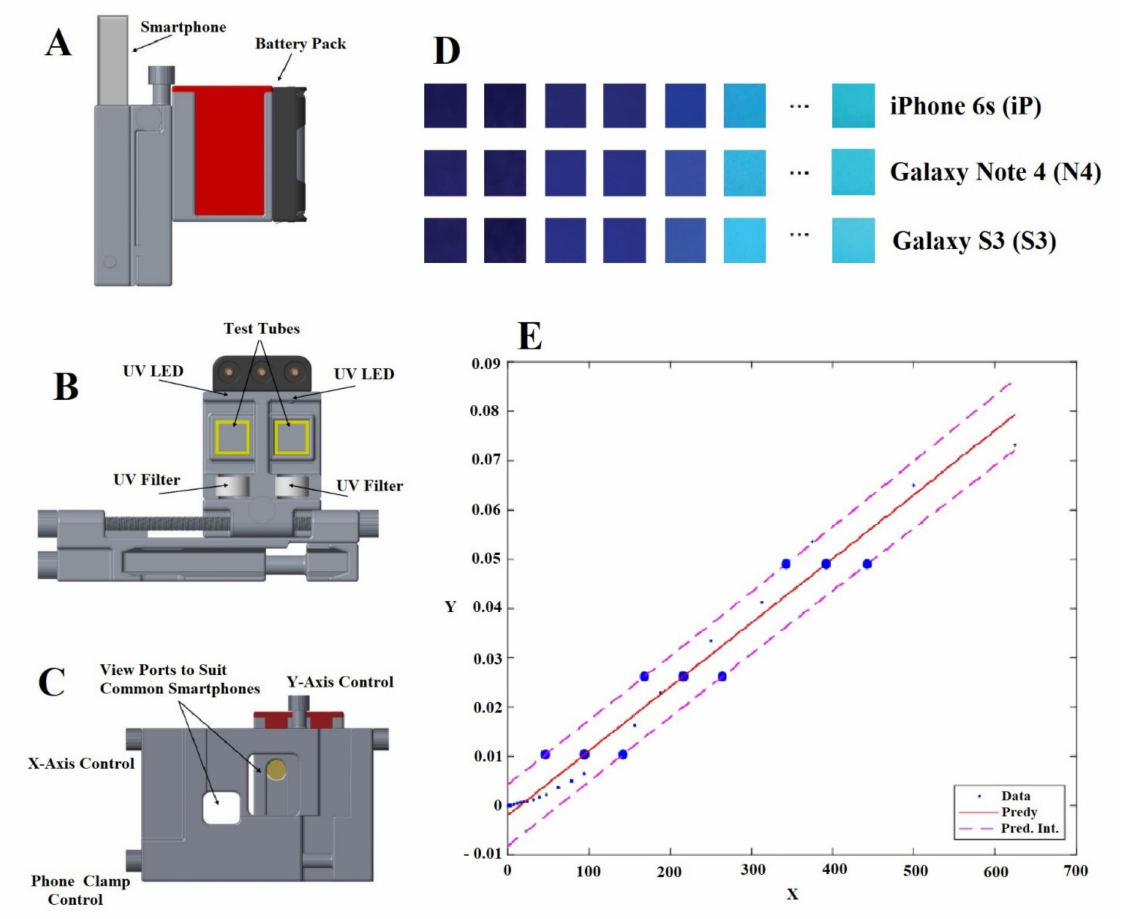
Figure 7. ( A ) external and ( B ) internal design of imaging housing attached to a smartphone and ( C ) adjustable viewports and clamp controls for the AIEgen-based 3D printing device. ( D ) Images of different HSA concentration levels taken by 3 smartphones after the AIEgen, BSPOTPE, was added. ( E ) Linear prediction model with internals with the x -axis of HSA concentration and the y -axis of light intensity of the AIEgen probe after it was combined with HSA